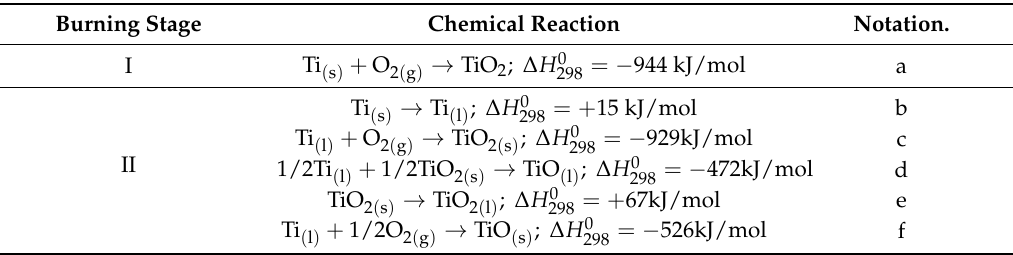
Table 2. Chemical reactions of titanium combustion in air [45]. Burning Stage Chemical Reaction Notation.